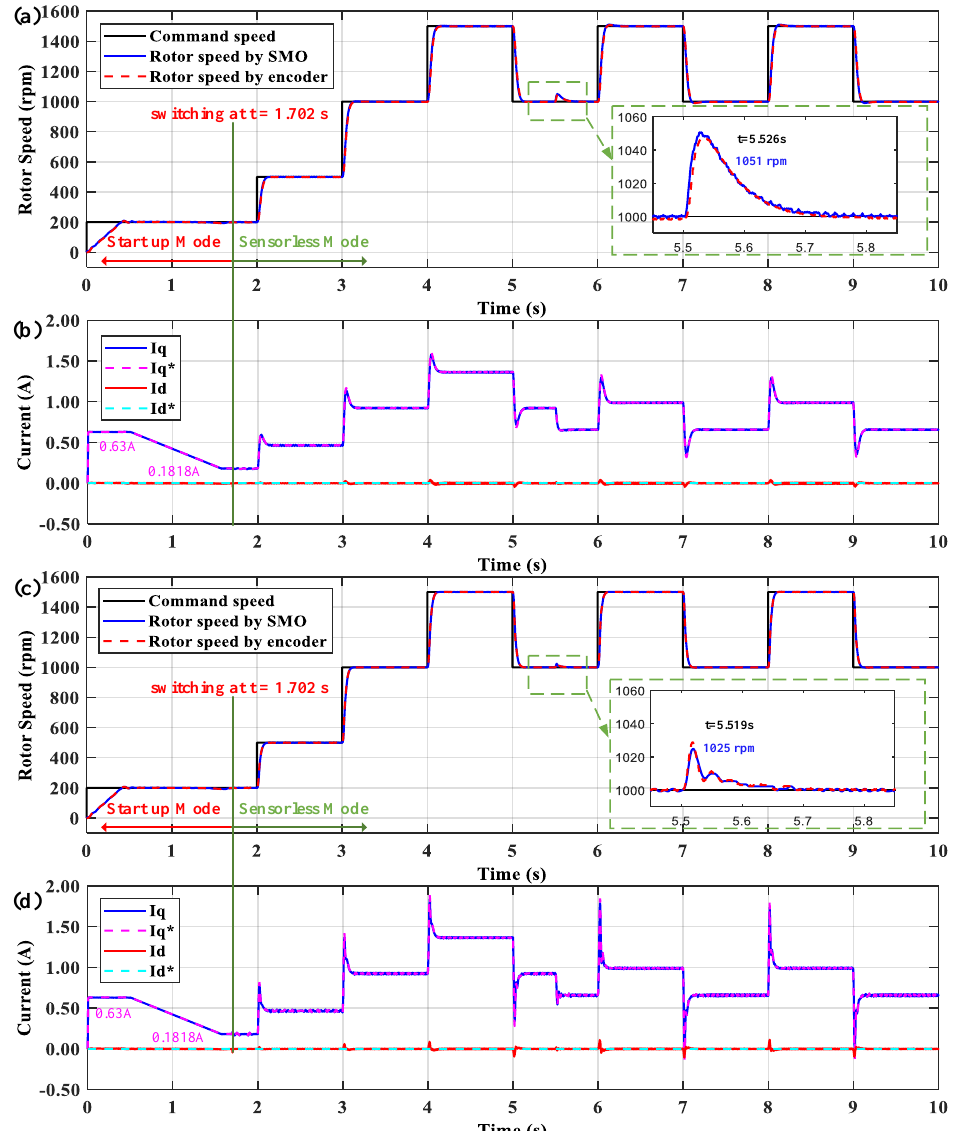
Figure 12. Simulation results for PI controller: ( a ) speed response; and ( b ) current response; and for NFC controller: ( c ) speed response; and ( d ) current response in the case of R L = 50 → 100 Ω.